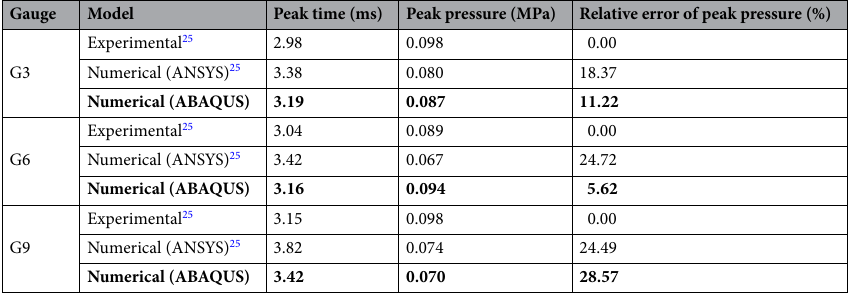
Table 2. Numerical outputs for peak times, peak pressures, and their associated errors in the verification model obtained from different experimental and numerical studies. Bold values are the results of our numerical simulations, whereas the other values are from the literature.